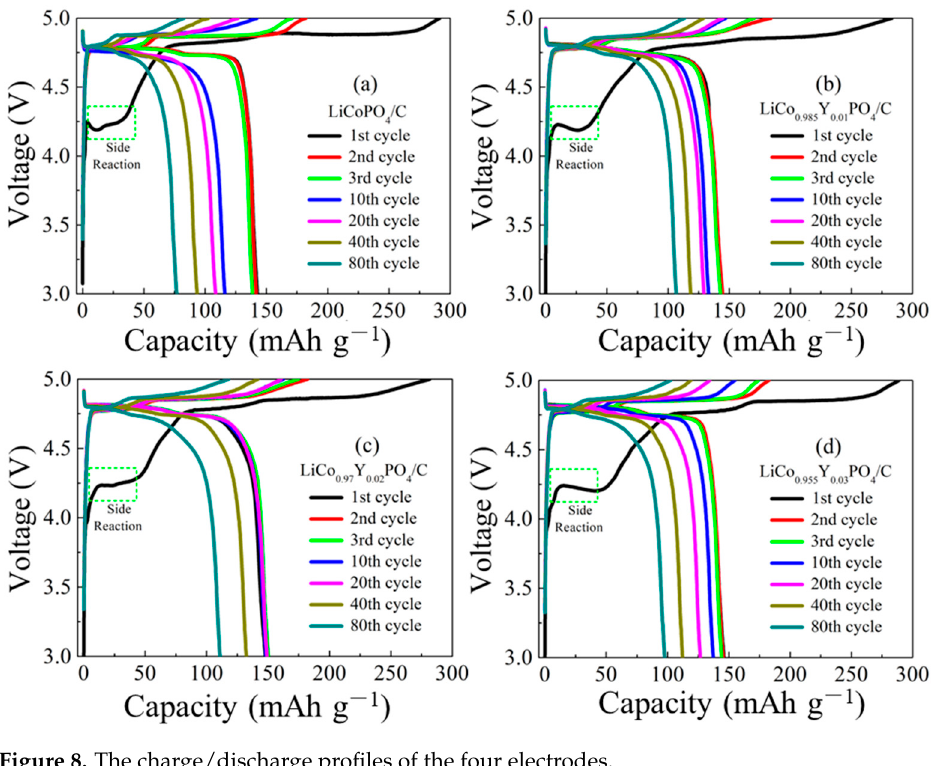
Figure 8. The charge/discharge profiles of the four electrodes.